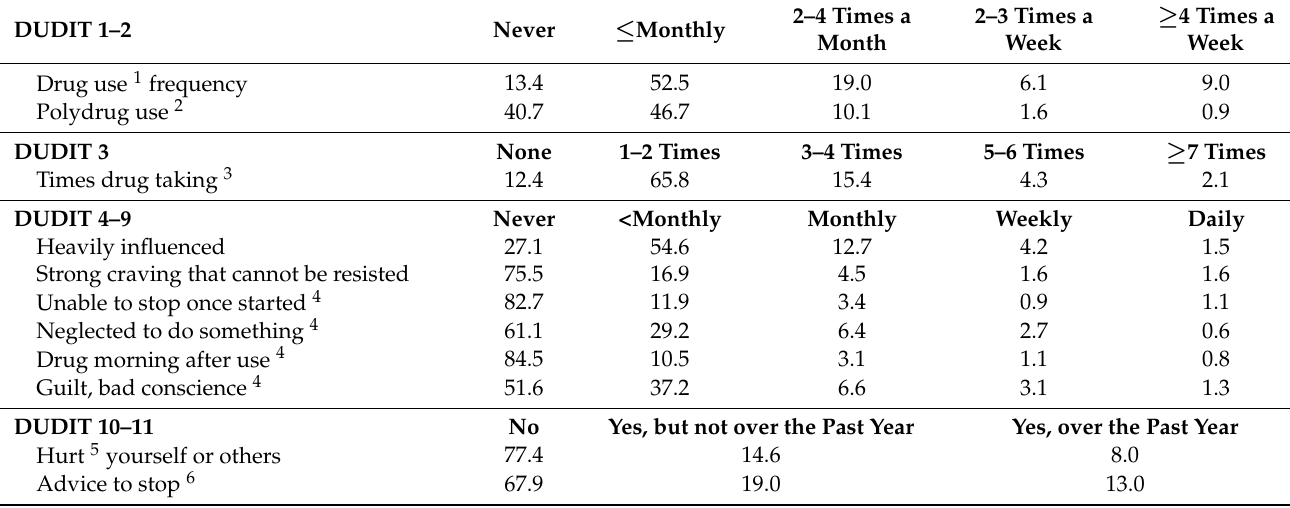
Table 7. DUDIT (Drug Use Disorder Identification Test) among drug users. Participants who had stated drug use during the last 12 months were asked to fill out the DUDIT. Data are presented as percentage of participants ( n = 889). There were no missing data. Questions relate to illicit drug